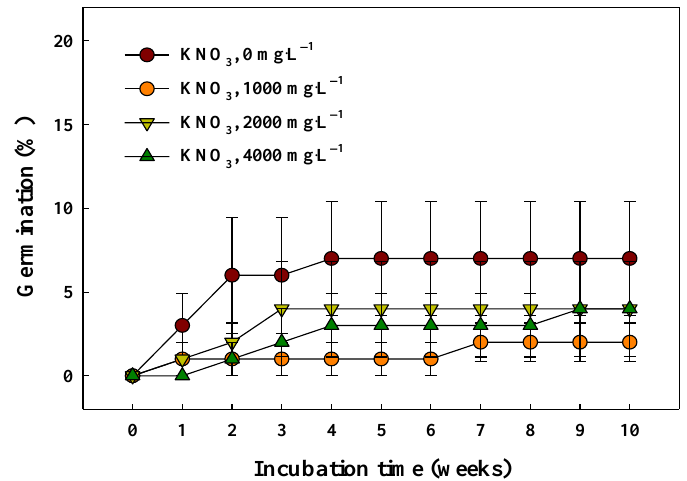
Figure 7. Cumulative germination of the Gentiana triflora var. japonica (Kusn.) H. Hara seeds pretreated with KNO 3 (0, 1000, 2000, or 4000 mg · L − 1 ). Vertical bars represent the standard deviation from the mean ( n = 4).